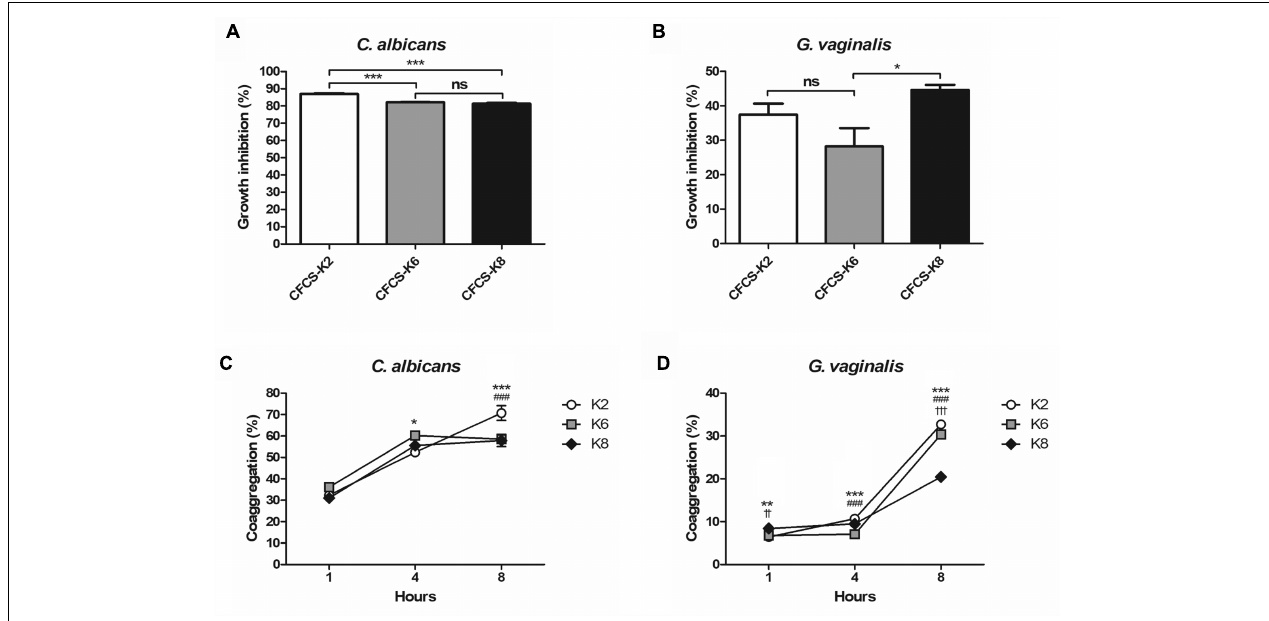
FIGURE 4 | Growth inhibition rates against (A) C. albicans and (B) G. vaginalis by cell free culture supernatant (CFCS) of L. plantarum ATG-K2, ATG-K6, and ATG-K8. Coaggregation of each strain of L. plantarum ATG-K2, ATG-K6, and ATG-K8 reacted with (C) C. albicans and (D) G. vaginalis . Data are expressed as mean ± SEM. Statistical significance in the figures are shown as follows: K2 vs. K6, ∗ p < 0.05, ∗∗ p < 0.01, ∗∗∗ p < 0.001; K2 vs. K8, ### p < 0.001; K6 vs. K8, †† p < 0.01, ††† p < 0.001.